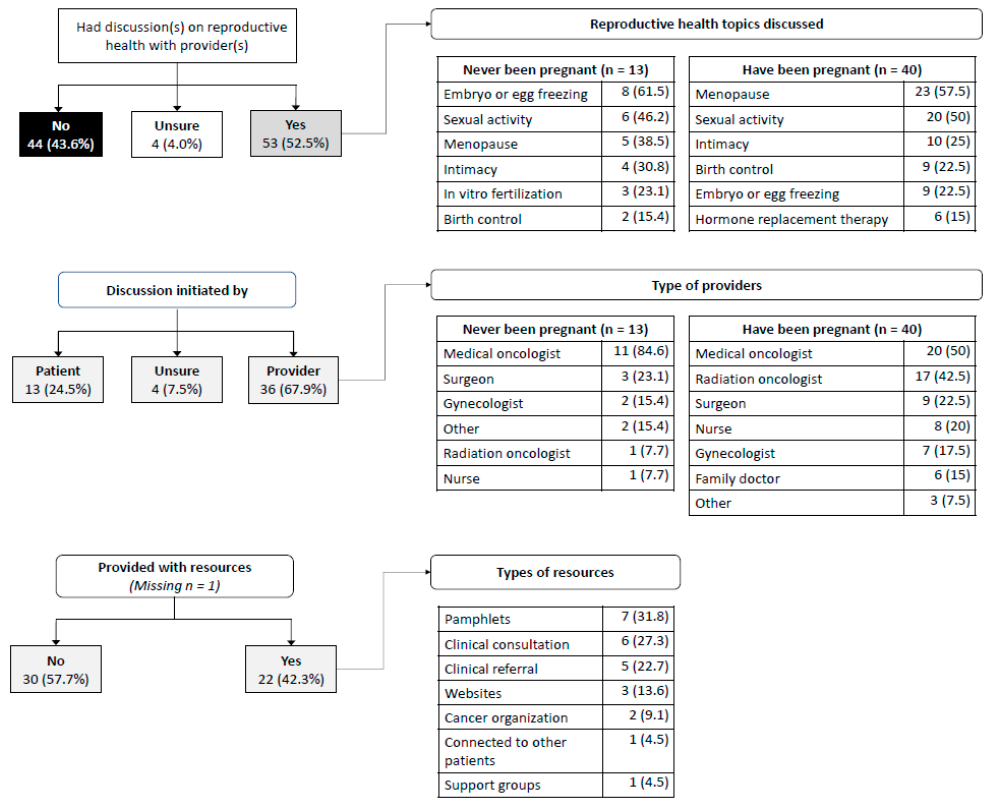
Figure 2. Experiences with having discussion(s) about reproductive health with healthcare provid- ers.